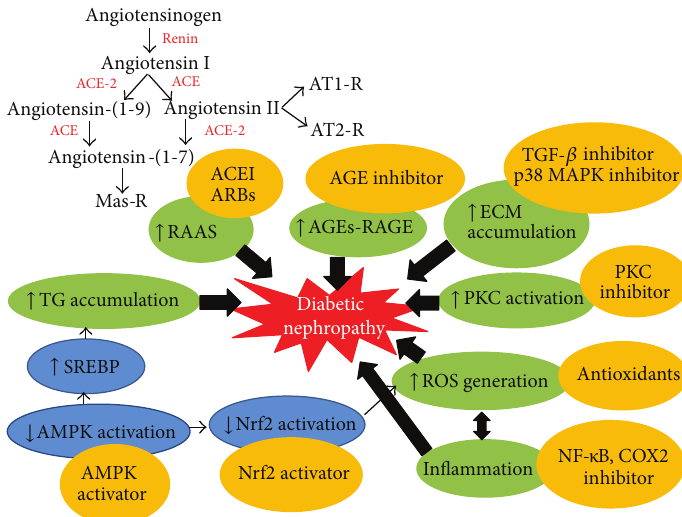
Figure 2: Current drug targets in diabetic nephropathy. Interrelated derangements in cellular hemodynamic, metabolic, oxidative stress, inflammation; lipid dysfunction, and extracellular matrix accumulation occur in diabetes and lead to diabetic nephropathy. These derangements provide the targets for the development of mechanism based